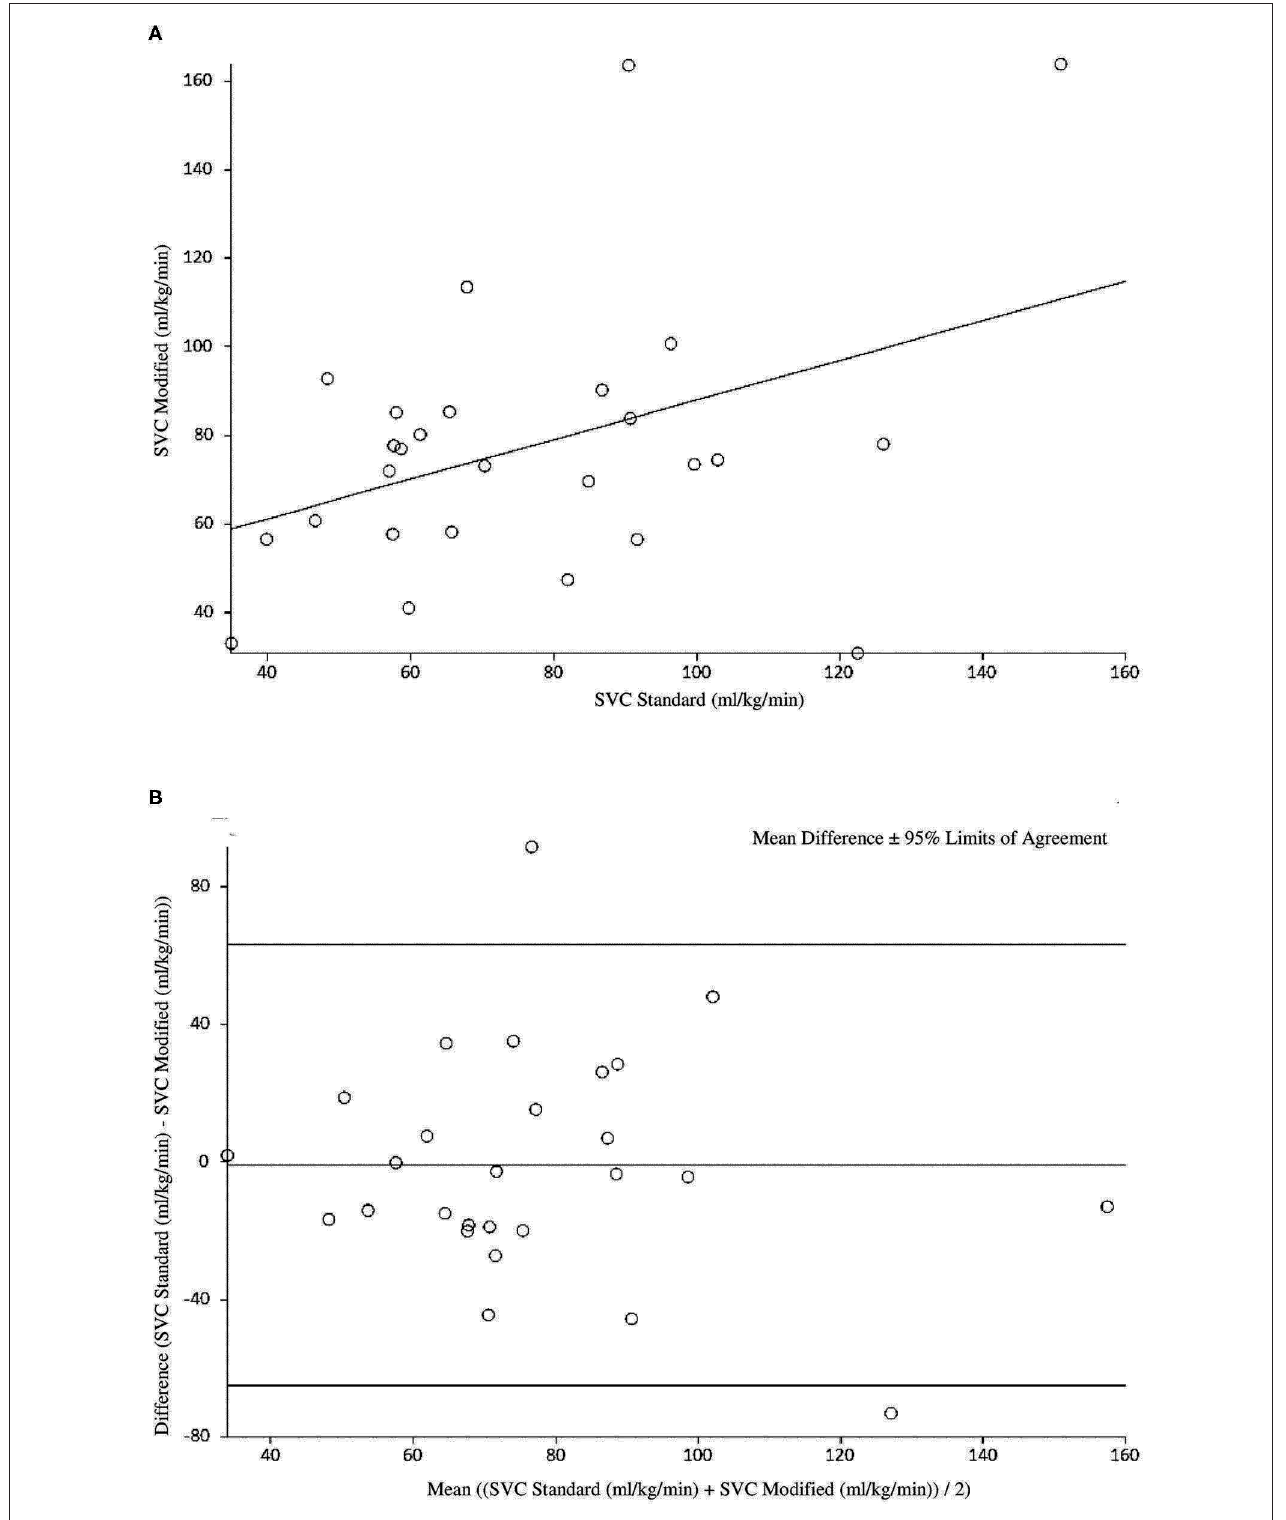
FIGURE 1 | (A) Correlation between standard and modified Superior Vena Cava (SVC) flow measurement at 6h of age. (B) Agreement between standard and modified Superior Vena Cava (SVC) Flow measurement at 6h of age with mean difference and 95% limits of agreement.